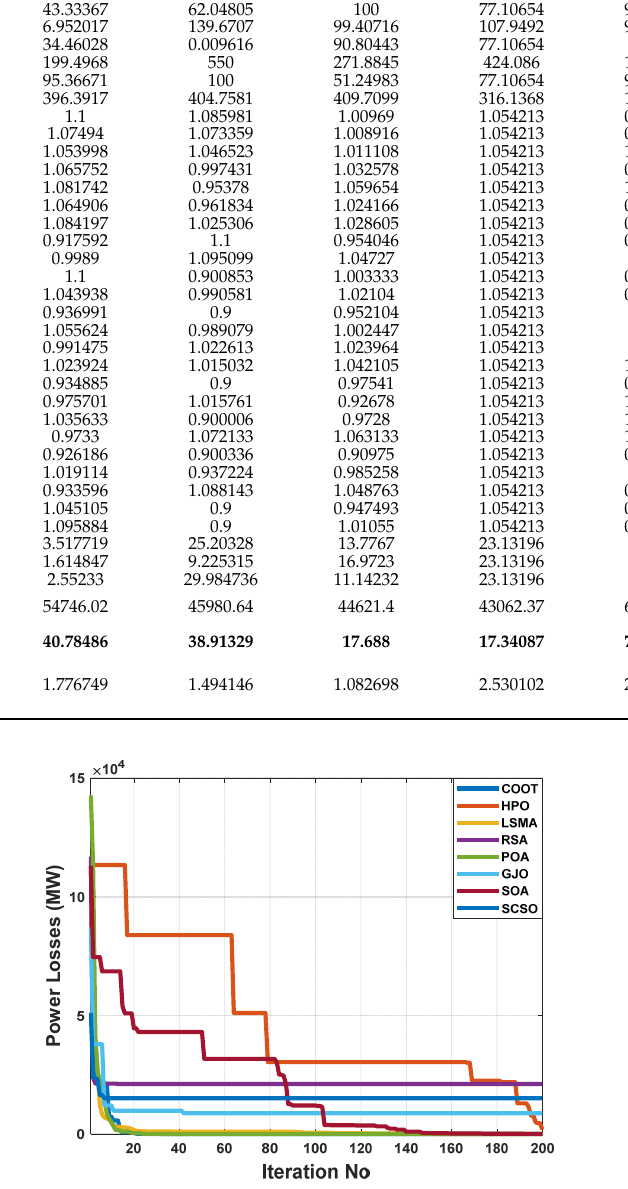
Figure 22. The convergence characteristics of POA and other compared algorithms for case 2 in a standard IEEE 57-bus test system.